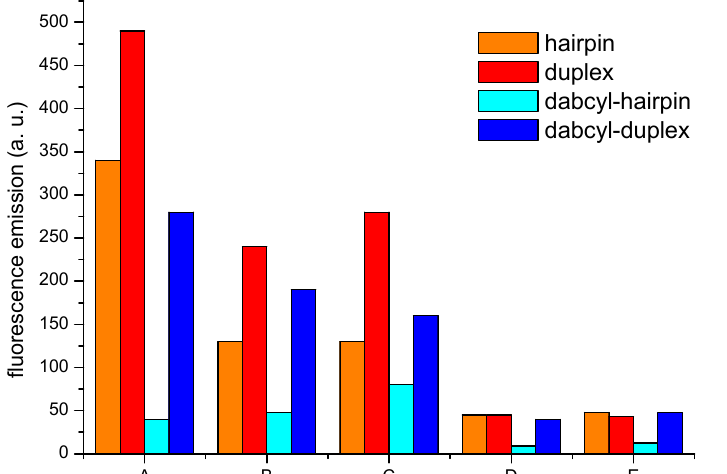
Figure 2. Fluorescence emission of each derivative ( A – E ) as: hairpin (orange), duplex (red), hairpin with dabcyl quencher (cyan), and duplex with dabcyl quencher (blue). All the experiments were performed at the same concentration of the respective oligonucleotides at room